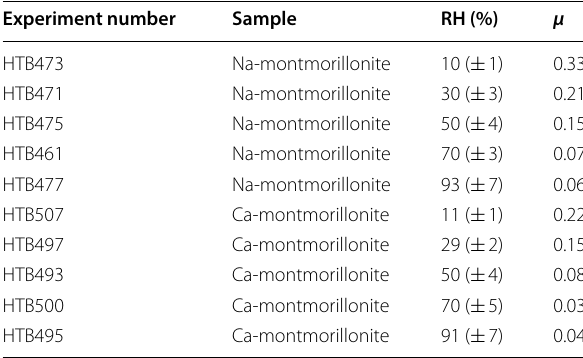
Frictional coefficient is calculated at shear displacement of 10 mm. All experiments are conducted at normal stress 10 MPa